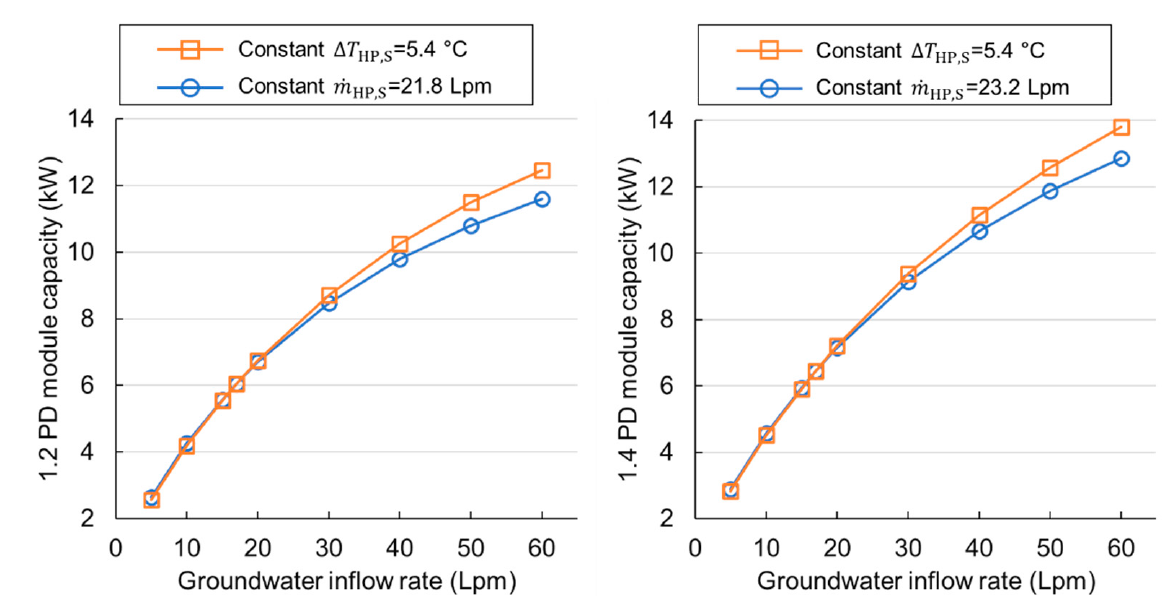
Figure 10. Sizing results for a single 1.2 ( left ), 1.4 ( right ) PD module capacity (kW).